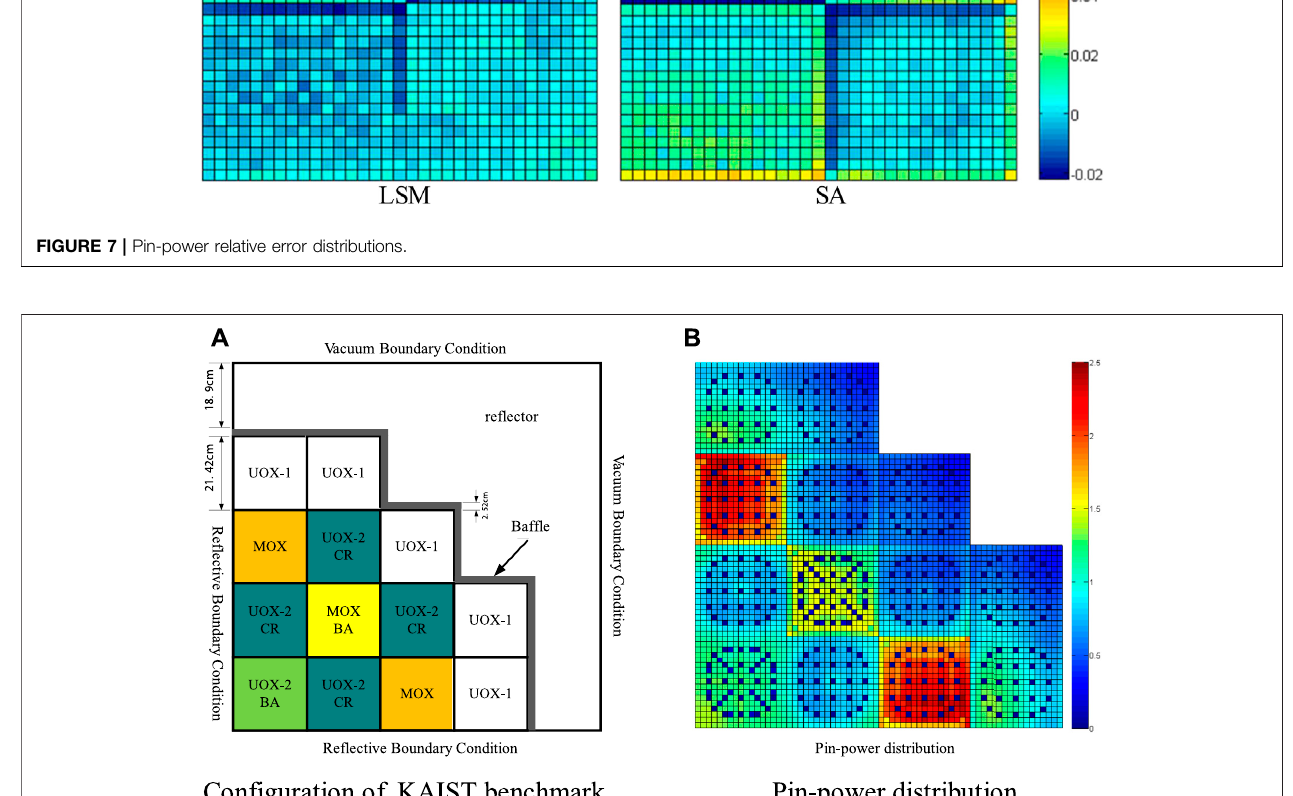
FIGURE 8 | 2D whole-core problem of KAIST benchmark. (A) Con fi guration of KAIST benchmark. (B) Pin-power distribution.